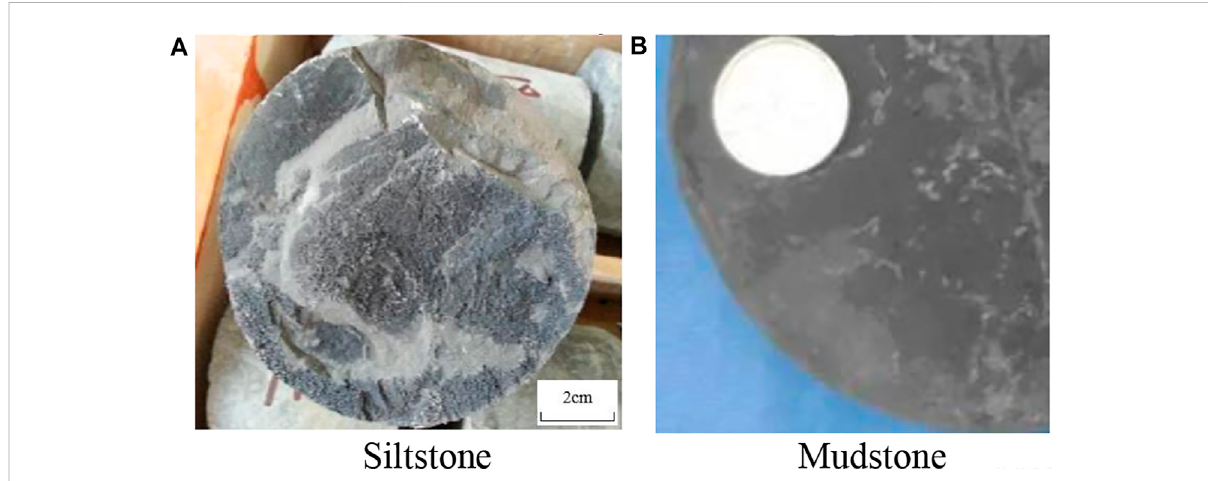
FIGURE 2 Photographs of representative rock samples from the H oil reservoir in the Liaohe Oil fi eld.